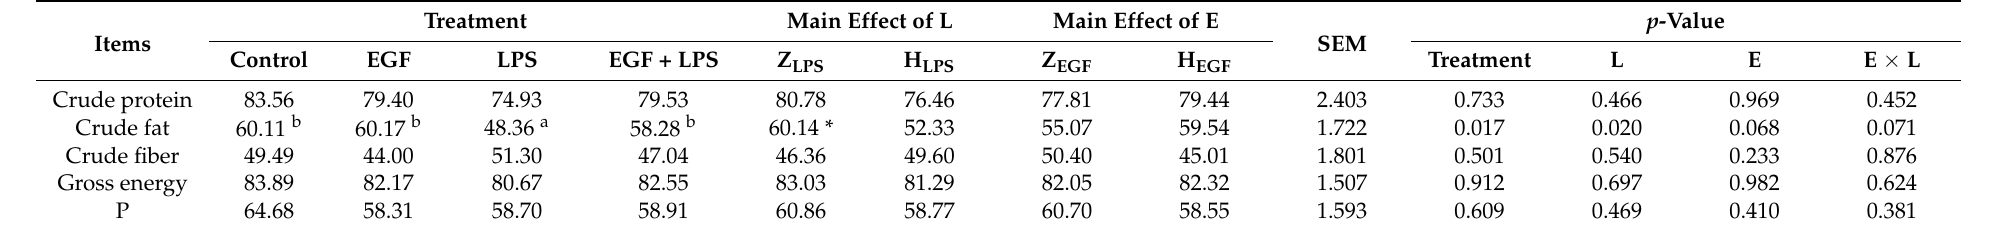
Table 4. EGF attenuates the effect of LPS on apparent nutrient digestibility in early-weaning piglets (dry